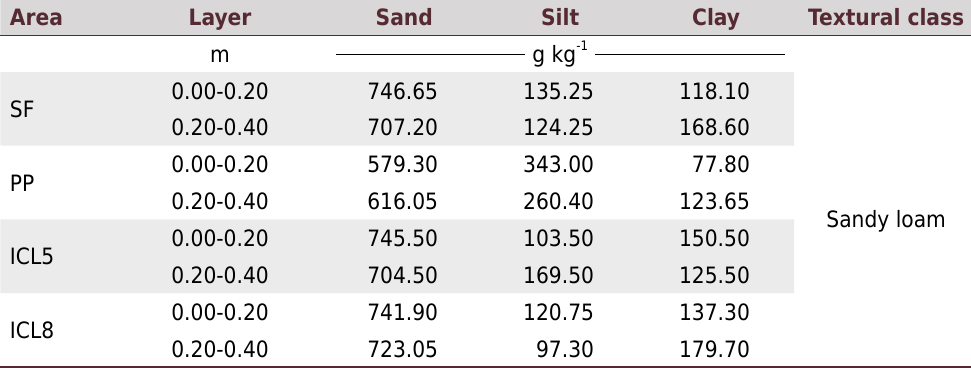
Table 1. Soil particle-size characterization in the different areas and layers in the Pindaré-Mirim region, Maranhão, Brazil Area